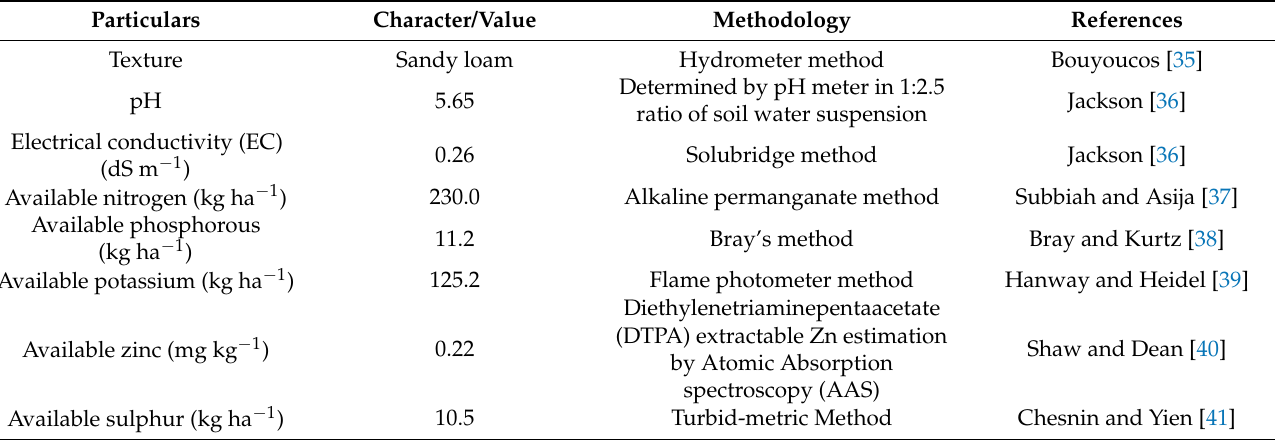
Table 1. Characteristics and initial fertility of the experimental soil and methodologies followed for their determination (June